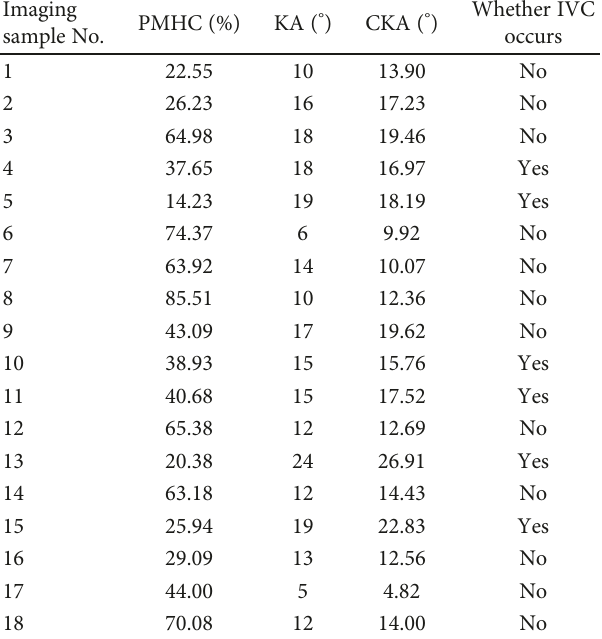
Figure 4: The values of VBCRs and PAHC measured from 18 sets of radiographs. Table 2: The PAHC, KA, CKA, and IVC data obtained in this